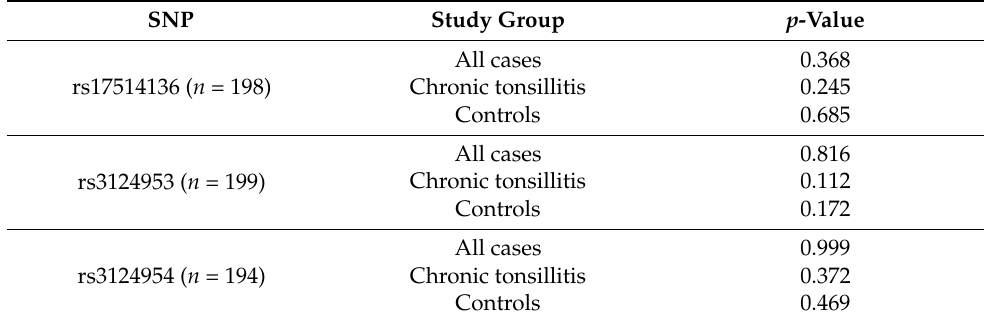
Table 3. Hardy–Weinberg equilibrium for FCN2